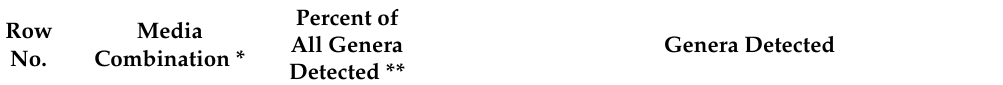
Table 2. Summary of the bacterial genera recovery using various media